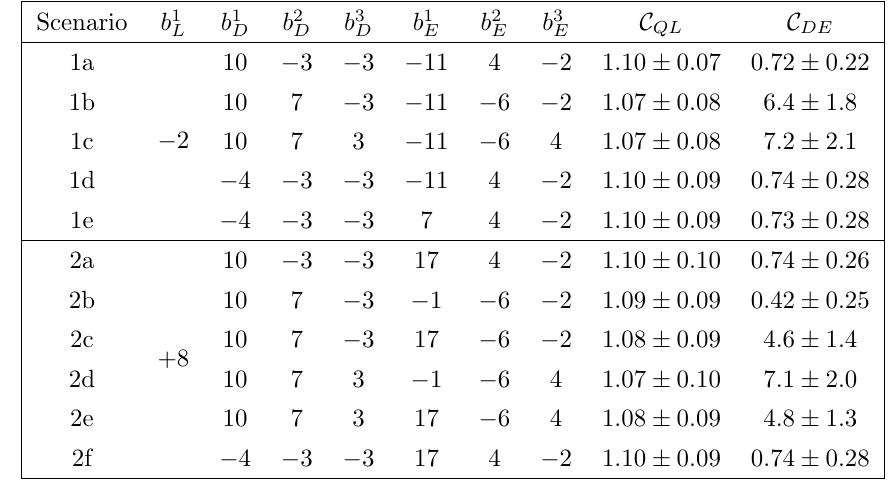
Table 4 . Viable solutions for FN charges identi(cid:12)ed from the